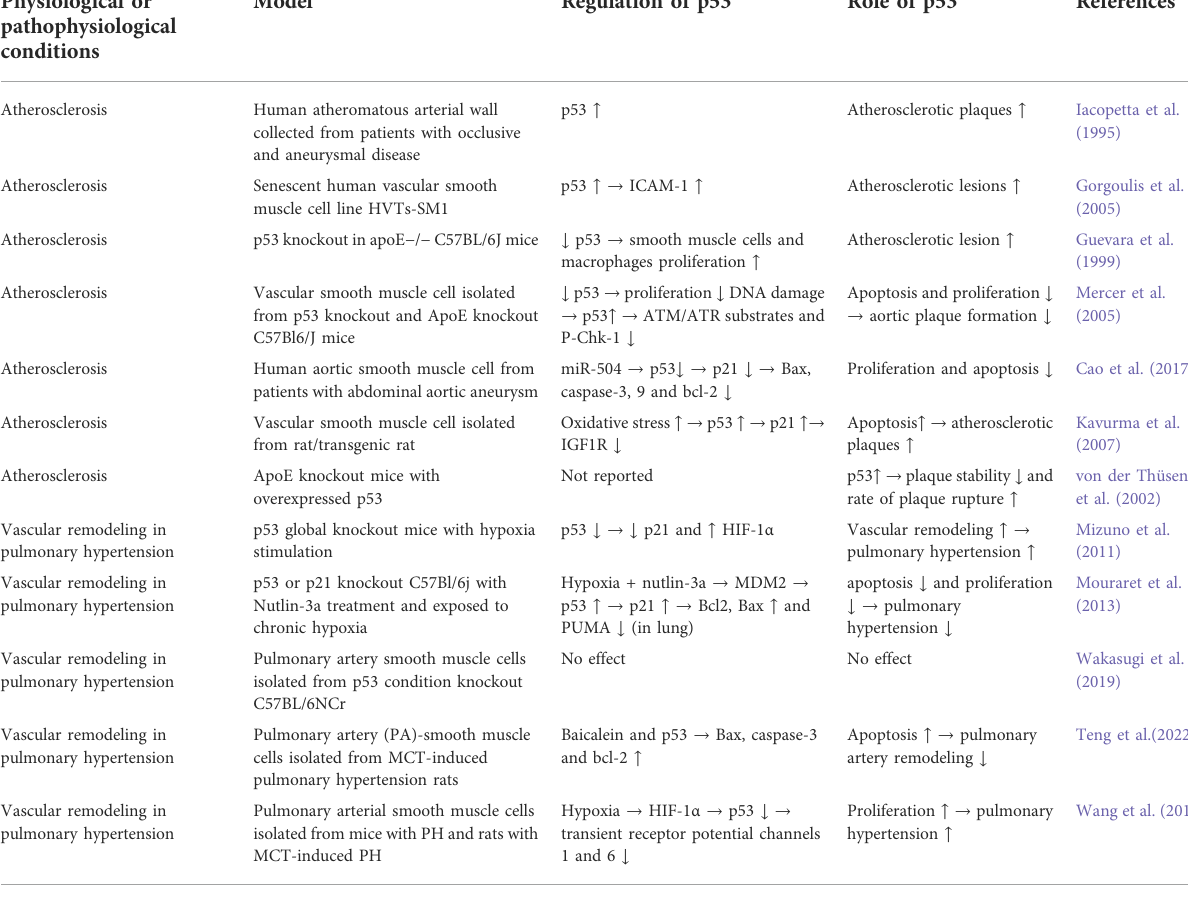
TABLE 2 Summary of regulation of p53 in smooth muscle cell under different physiological or pathophysiological conditions. Physiological or pathophysiological